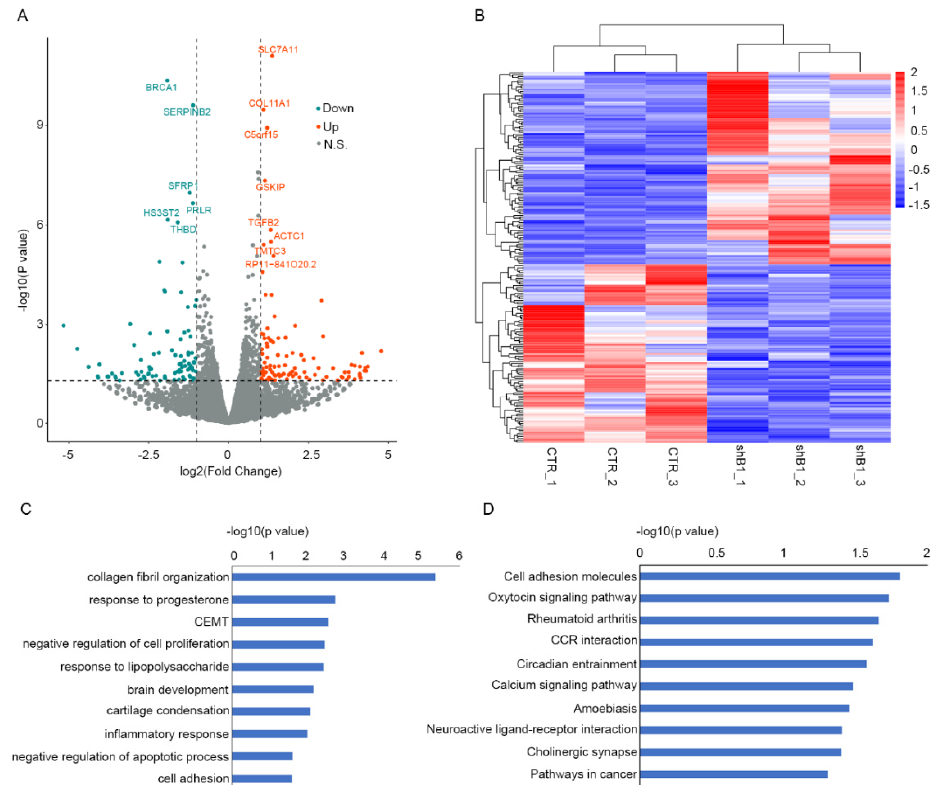
Figure 4. BRCA1 associates with molecular events related to keloid formation in normal DF. ( A ) Volcano plot illustrating the log2-based fold change (X-axis) and significance (Y-axis, log10-based p value) of differential expression analysis between shB1 and shSCR DF samples. Blue and red dots are significantly down- and upregulated genes in normal shB1 DF relative to normal shSCR DF, respectively. Dark grey dots represent non-significantly differential expression genes. ( B ) Heatmap of z-score normalized expression values of DEGs in normal shB1 and shSCR DF. ( C ) and ( D ) represent the significantly enriched GO terms and KEGG pathways of DEGs, respectively. CEMT, cardiac epithelial to mesenchymal transition.